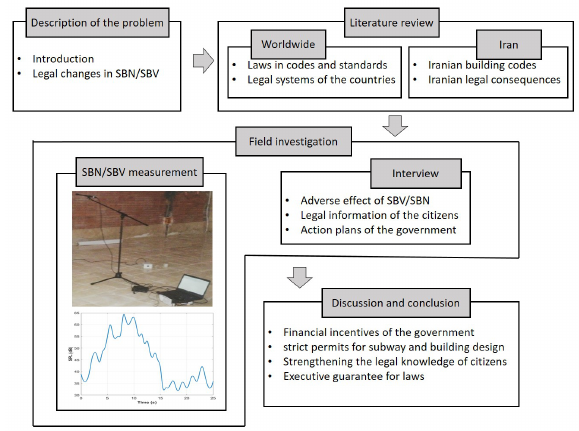
Figure 1: The flowchart of